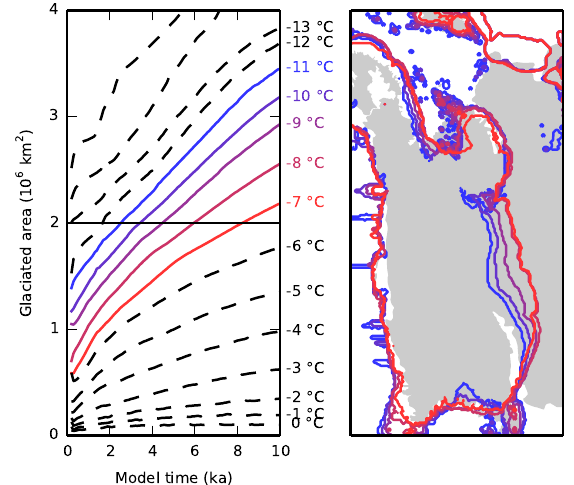
Figure 16. Left panel: model sensitivity to simulation length. Mod- elled glaciated area, using NARR forcing data, and temperature off- sets from − 15 to 0 ◦ C, solid lines corresponding to values from − 11 to − 7 ◦ C. Right panel: modelled ice margin corresponding to temperature offsets from − 11 to − 7 ◦ C when total glaciated area reaches the approximate size of the LGM Cordilleran ice sheet of 2 × 10 6 km 2 . A reconstructed LGM ice sheet margin by Dyke (2004) (Fig. 1) is given for reference (grey shading). Note that shorter (and colder) simulations lead to more restrictive glaciation of the conti- nental eastern margin but further ice extent in the maritime south- western part of the modelling